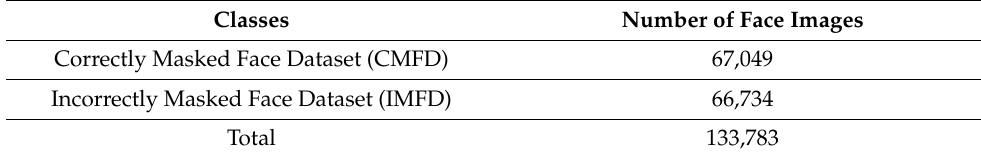
Table 5. The properties of MaskedFace-Net